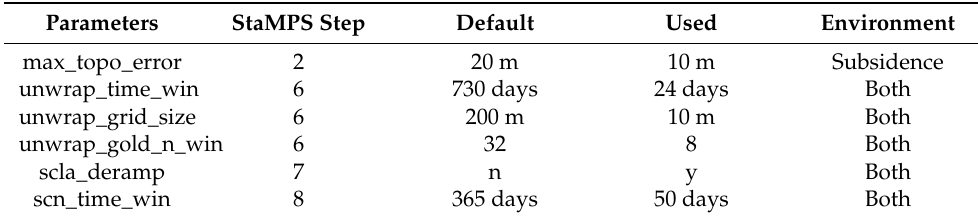
Table 2. List of StaMPS parameters used in this research. The Default and the Used values together with the involved StaMPS steps are shown. Note that max_topo_error has been changed only for the two subsidence test